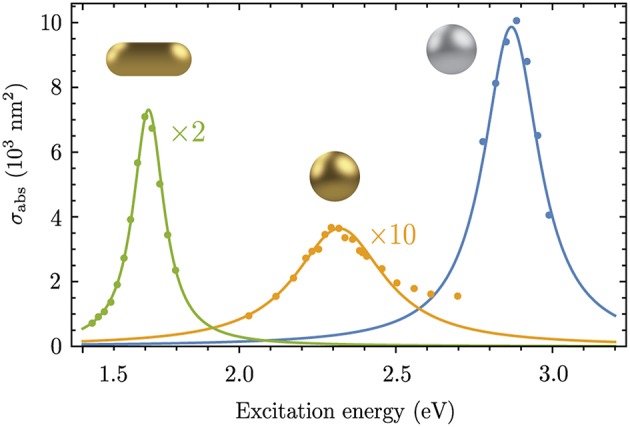
Experimental and calculated (Equation 26) optical absorption cross sections for a gold nanorod (green, Lombardi et al., 2012), a gold nanosphere (orange, Billaud et al., 2007) and a silver nanosphere (blue, Muskens et al., 2006). The nanoparticle volume Vp was taken from the experimental works. The following parameters were used to reproduce the experimental spectra: ℏωpl = 1.71 eV, ℏγpl = 60 meV, ϵm = 2.02 and L = 0.12 for the Au nanorod; ℏωpl = 2.32 eV, ℏγpl = 175 meV, ϵm = 1.96 and L = 1/3 for the Au nanosphere; ℏωpl = 2.87 eV, ℏγpl = 108 meV, ϵm = 2.31 and L = 1/3 for the Ag nanosphere.